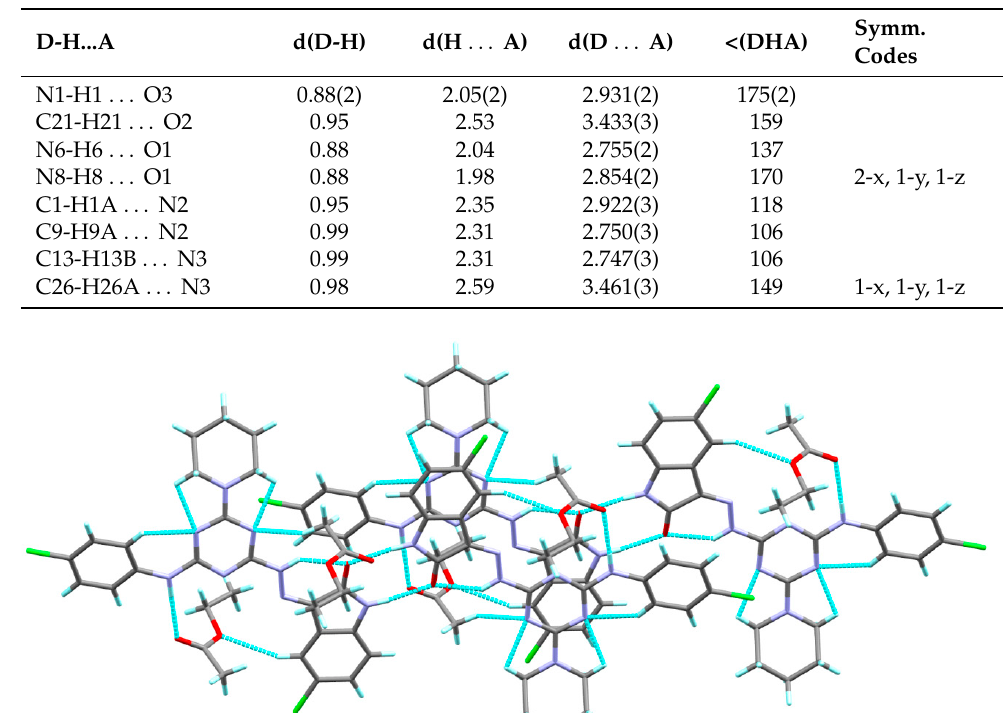
Figure 2. Possible intra- and intermolecular contacts in 6c . Table 3. Hydrogen bonds for 6c [Å and °].